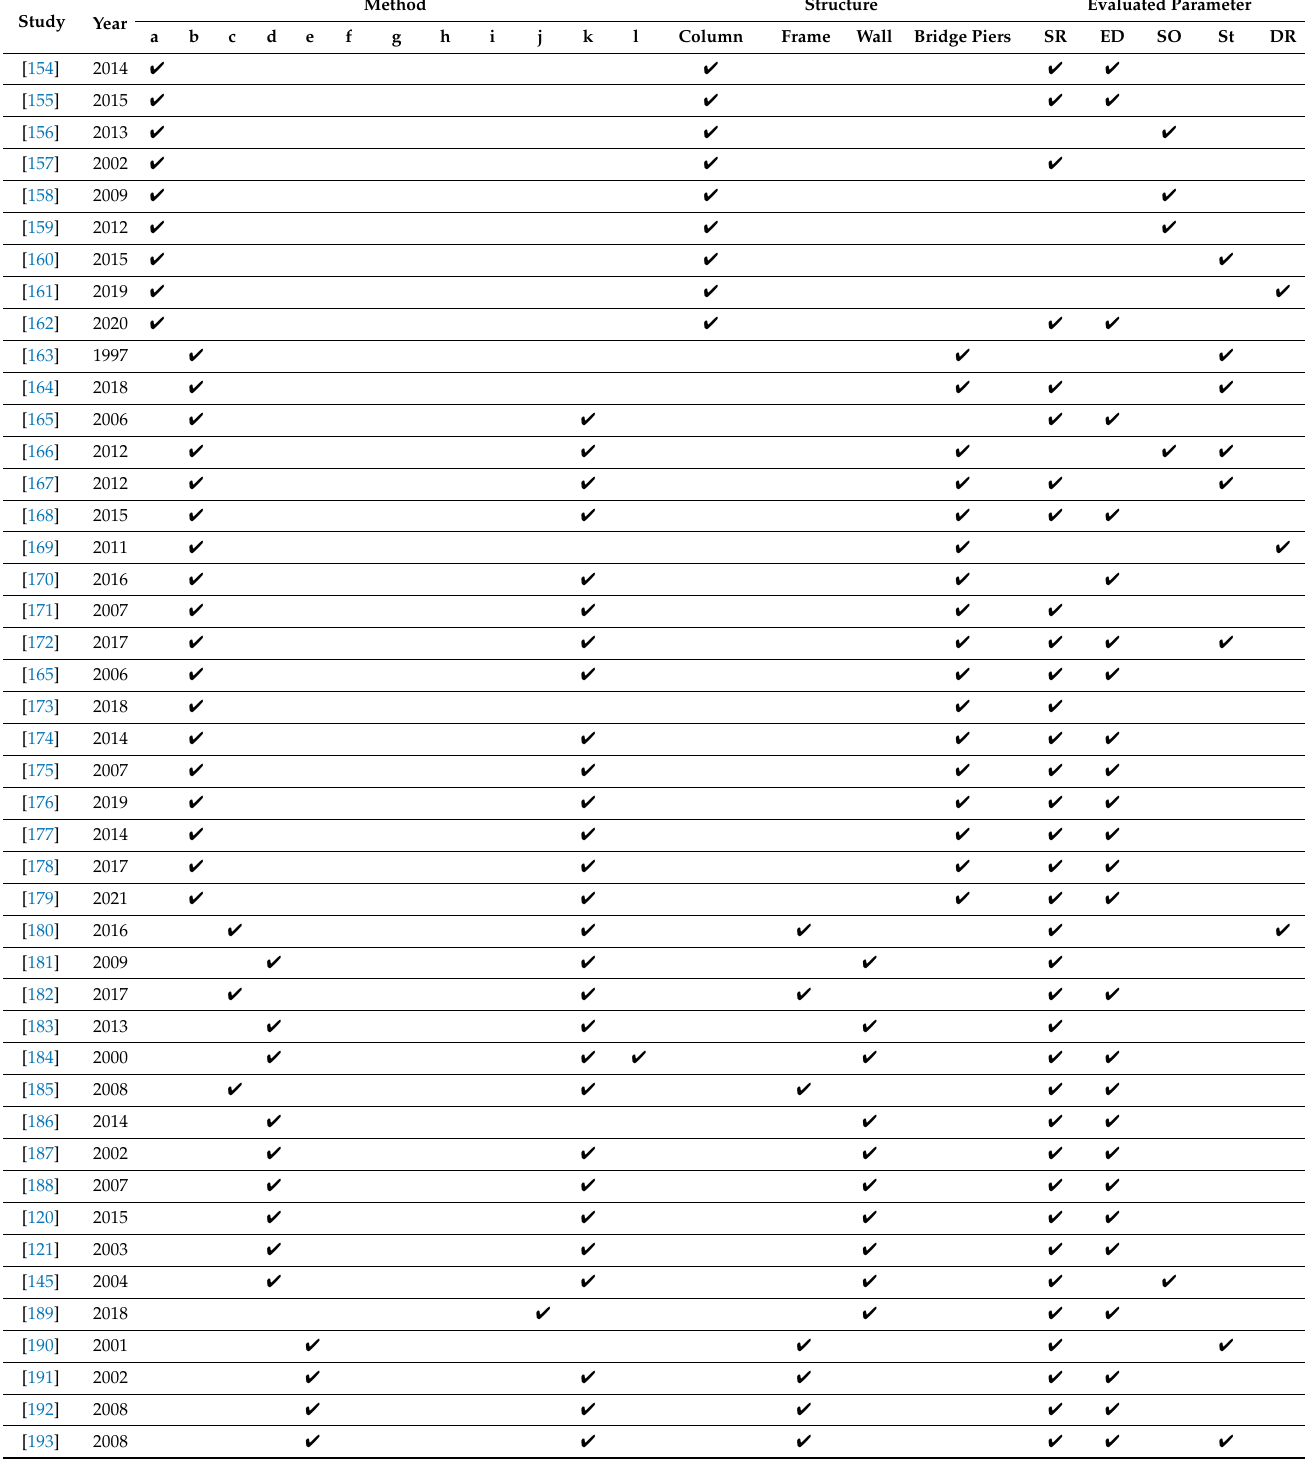
Table 2. Summary of self-centering studies regarding method, structural components, and evaluated parameters. Note: a—rocking podium structures, b—rocking piers for bridges, c—rocking RC frames, d—rocking RC walls, e—rocking steel frames, f—rocking timber frames, g—rocking timber centering capacity or residual displacement, ED—energy dissipation, SO—stability and overturning, St—stiffness, and DR—other dynamic